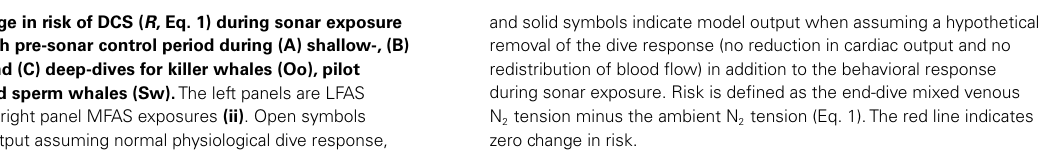
and solid symbols indicate model output when assuming a hypothetical removal of the dive response (no reduction in cardiac output and no redistribution of blood flow) in addition to the behavioral response during sonar exposure. Risk is defined as the end-dive mixed venous N 2 tension minus the ambient N 2 tension (Eq. 1).The red line indicates zero change in